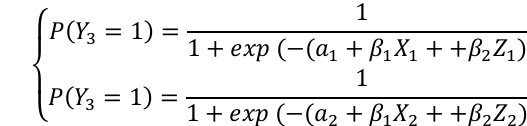
Figure 4. The relationship between age and the dependent variable   and the two explanatory var- iables   and   .